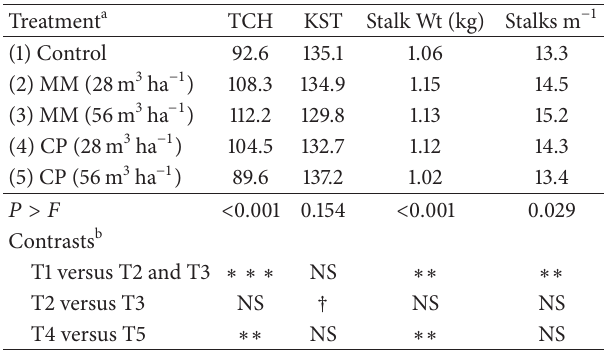
Table 6: Predicted least squares means and 𝑃 > 𝐹 for yield components including t cane ha −1 (TCH) and kg sucrose t −1 cane (KST) for the first ratoon crop at Site 2. Also included are significant